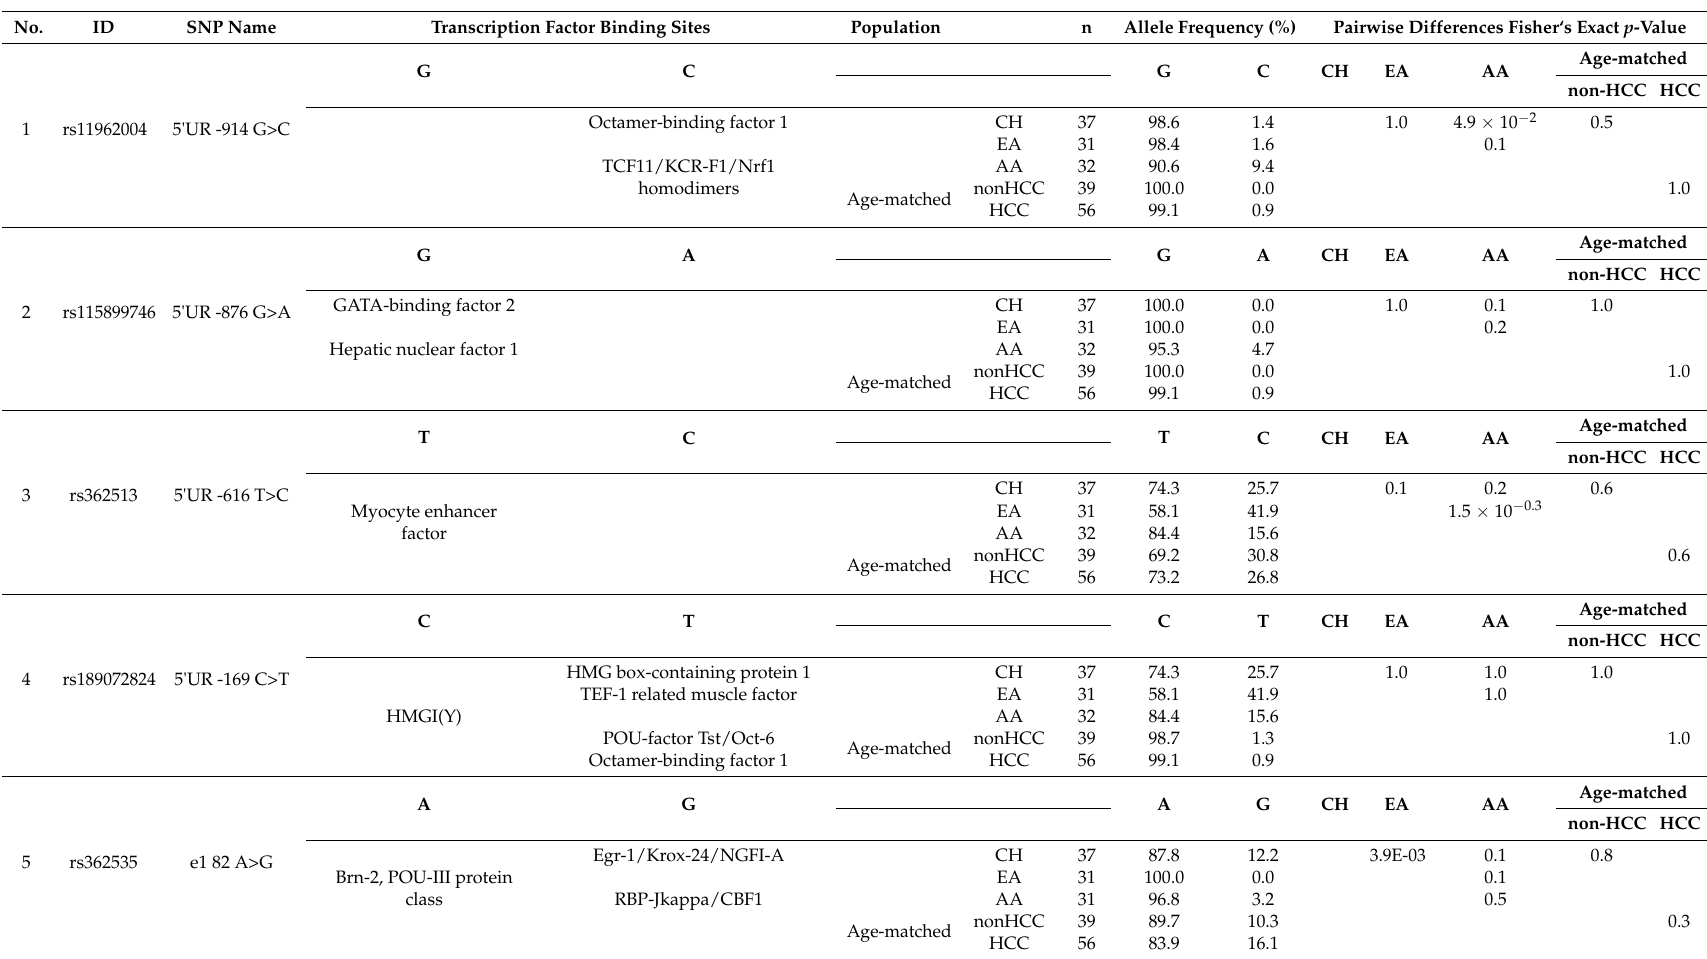
Table 1. Profile of allele frequency of single nucleotide polymorphisms (SNPs) at the FAT10